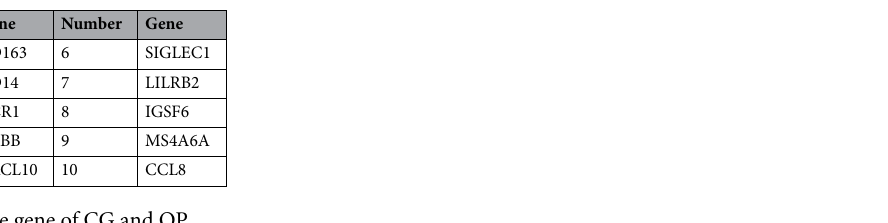
Table 6. Core gene of CG and